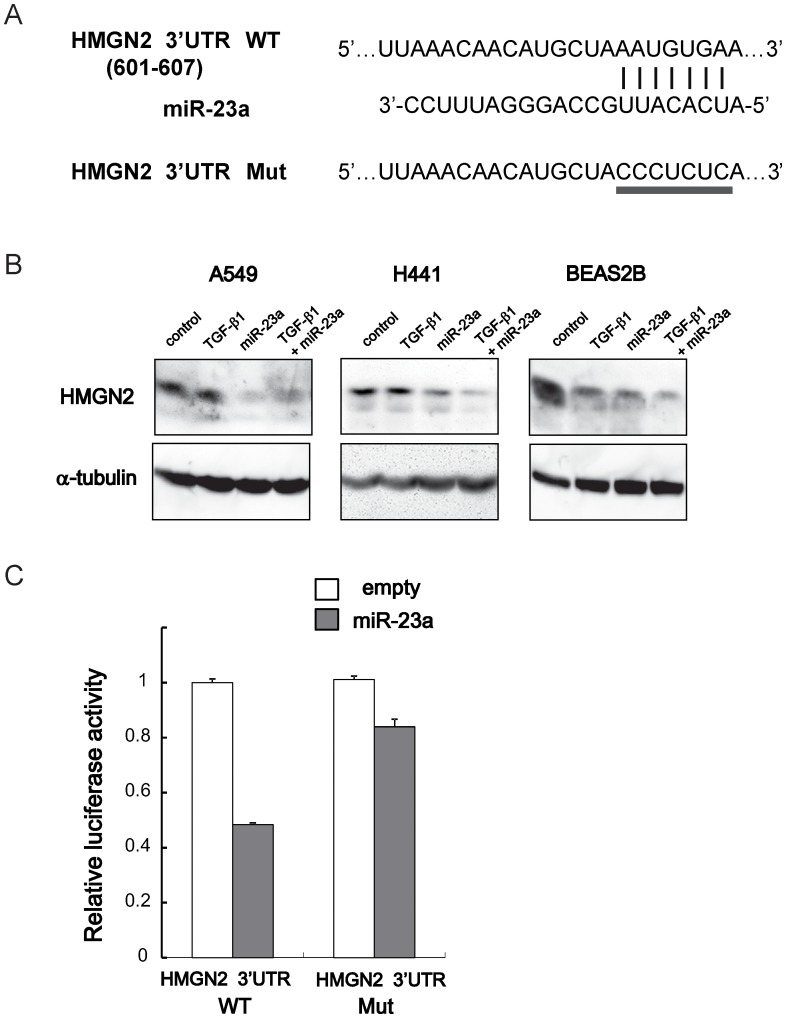
HMGN2 is regulated by miR-23a.(A) Putative miR-23a binding sequence in the 3′UTR of human HMGN2 mRNA (WT: wild-type). The underlined sequence shows the nucleotides generated by mutagenesis to abolish the binding of miR-23a (Mut: mutant). (B) Immunoblotting for HMGN2 in A549, H441 and BEAS2B cells transfected with control or synthetic pre-miR-23a for 48 h, followed by TGF-β1 stimulation for additional 48 h. α-tubulin was used as loading control. (C) HEK293T cells were transfected with luciferase reporters containing the HMGN2 3′UTR with wild-type or mutated target site as shown in Fig. 6A, along with empty or pri-miR-23a expression vector. Luciferase assay was performed 48 h after transfection.